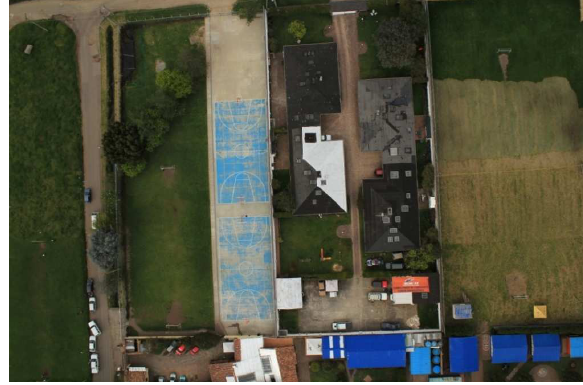
Spectral Difference